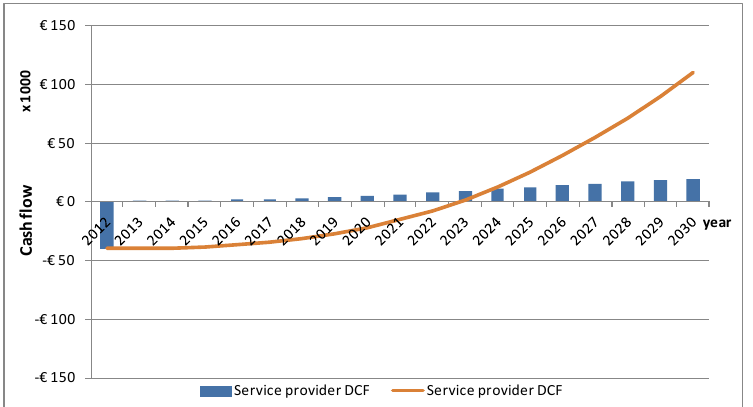
Figure 14. Evolution of the NPV for the charging service provider (scen.